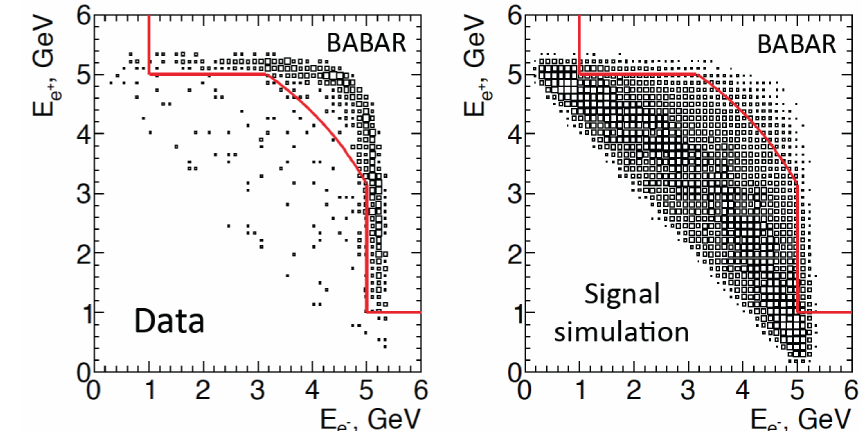
Figure 3. Scatter plots for (left) data and (right) signal event simulation of the final-state positron c.m. energy versus the final-state electron c.m. energy. Events below and to the left of the solid (red) line are